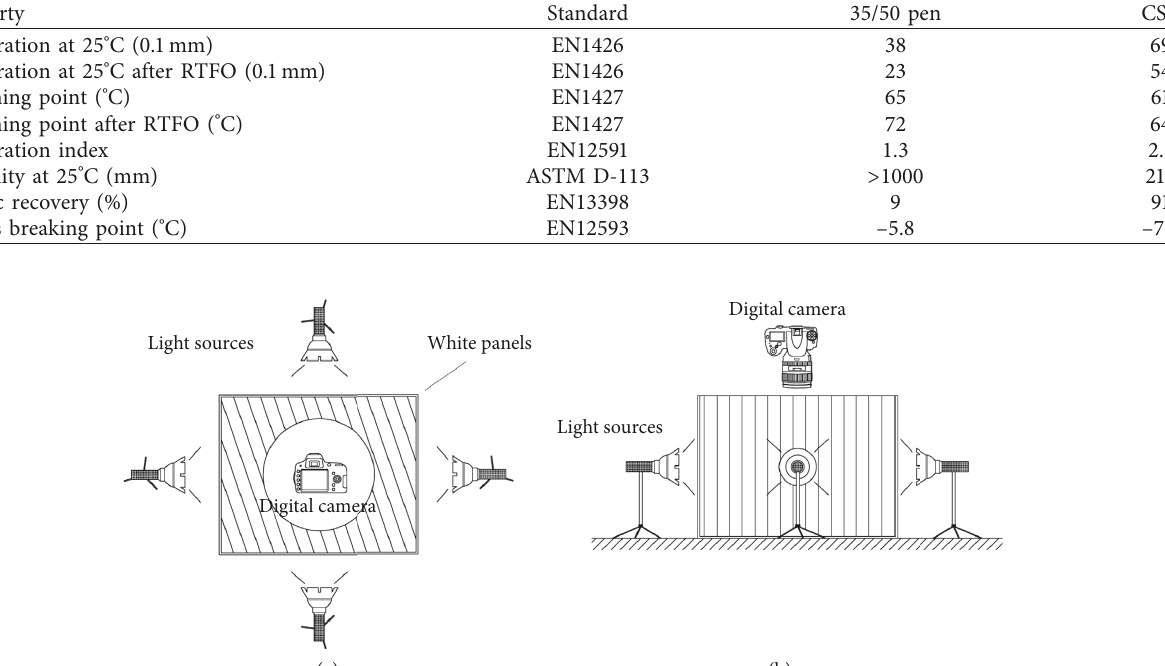
Table 1: Basic properties of tested binders.